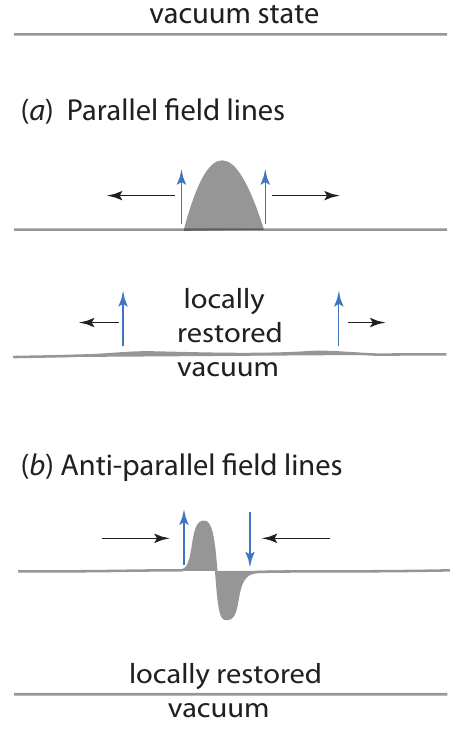
Fig. D1. Topological distortion of vacuum by two field lines. (a) Two parallel field lines (blue ↑↑ ) placed at small distance with their gauge fields causing distortion of vacuum in space between field lines. The vacuum restores its state locally by pushing the two field lines apart (black arrows) in opposite directions. (b) Two anti- parallel field lines (blue ↑↓ ) causing a sinusoidal distortion. The vacuum state is restored by attraction when the field lines annihilate over some parallel part